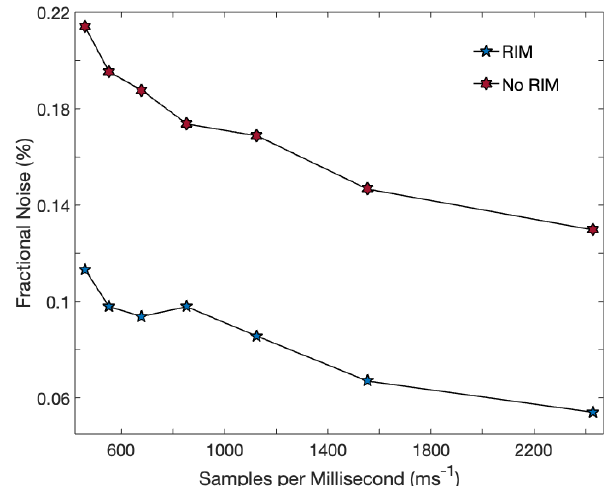
Figure 6. Fractional noise as a function of scan rate of the laser. The number of samples per scan was held constant, so a larger number of samples observed by millisecond (ms) indicates a higher scan rate. Two important trends are illustrated: total fractional noise is lower with faster scan rates, and fractional noise is lower when the RIM is incorporated into the optical